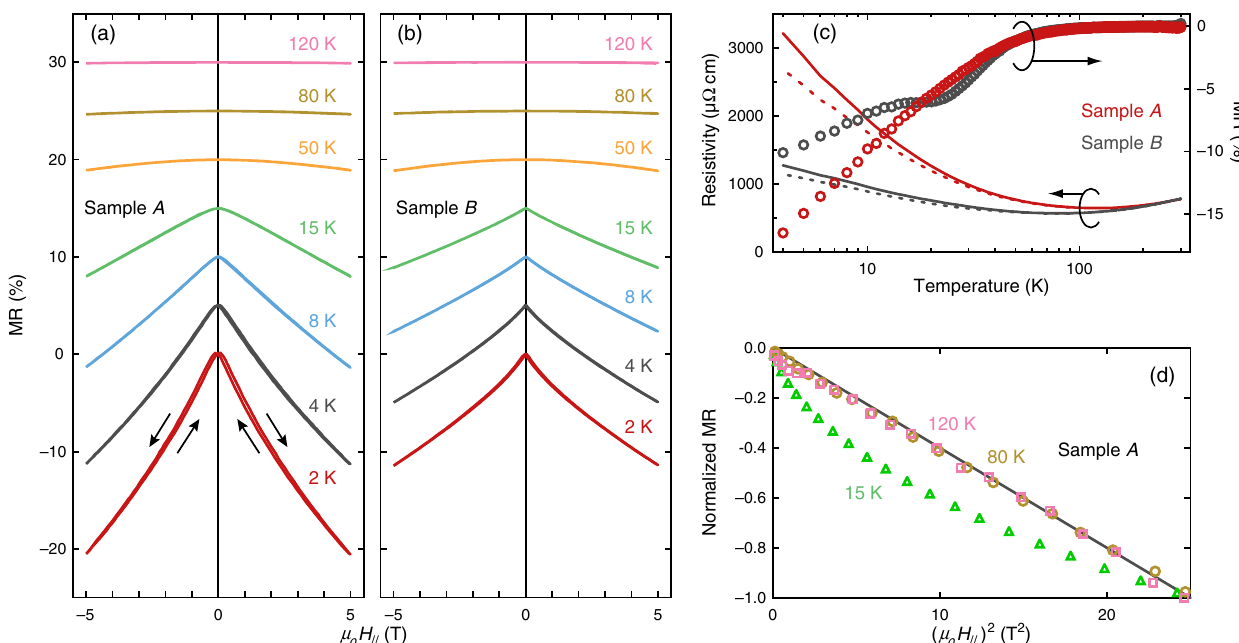
FIG. 10. Magnetoresistance for a parallel magnetic field. (a) MR curves at different temperatures for sample A . The magnetic field is applied parallel to the sample surface. Arrows denote the direction of the sweep. The MR curves are offset to avoid overlap. (b) MR curves for sample B . (c) The temperature dependence of the sheet resistance at H dependence of the MR ½ ρ ð 0 Þ − ρ ð 5 Þ(cid:3) = ρ ð 0 Þ . (d) The MR ð H 2 Þ dependence of sample A . Below 80 K, deviations from linear behavior are observed. The MR curves are normalized to their values at H ¼ 5 T.